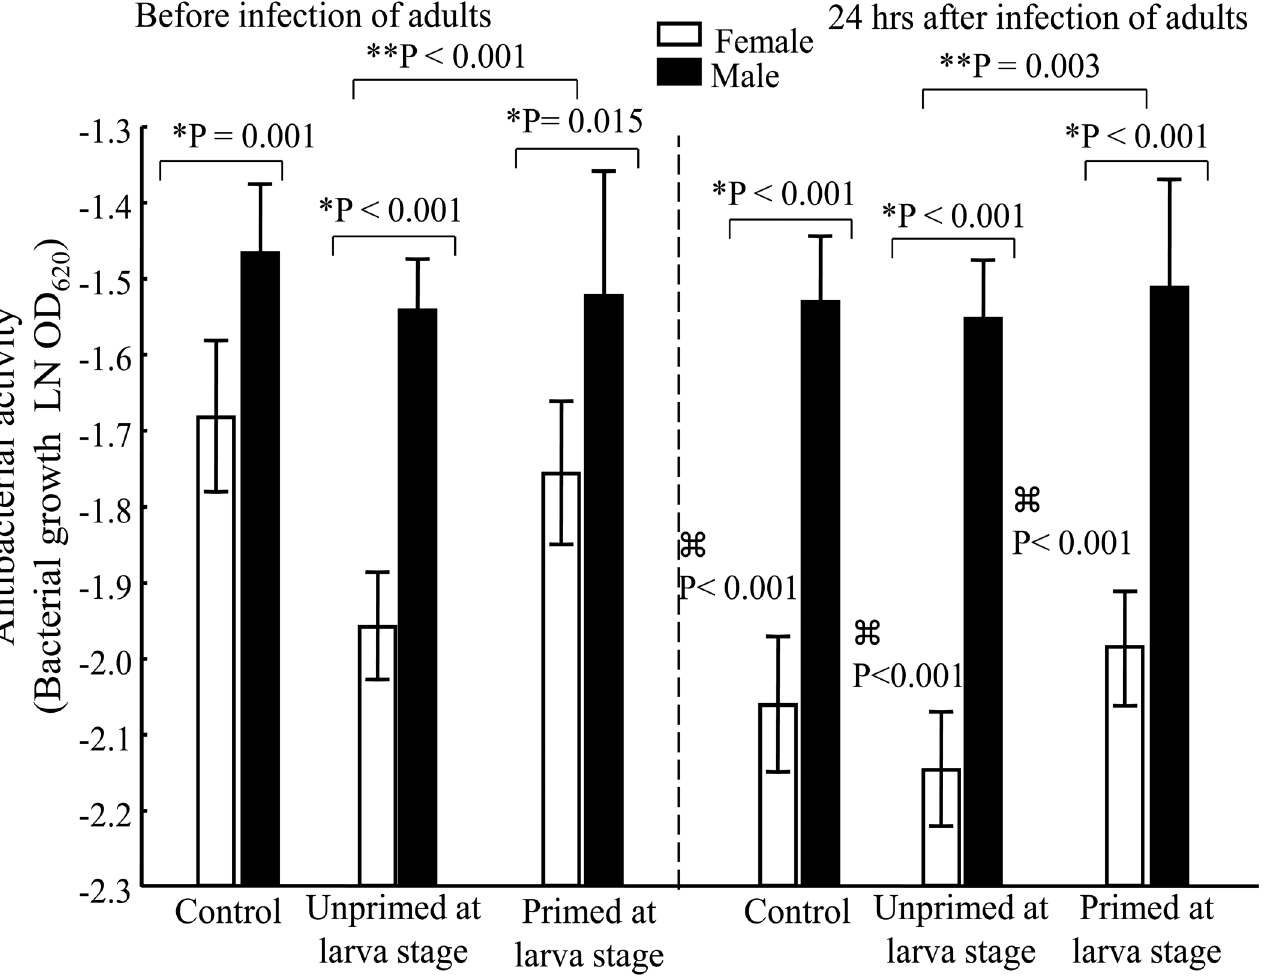
Fig 6. Antibacterial activity of adult mosquitoes before and after infection with E . coli . Higher readings indicate weak antibacterial activity. ( * ) indicates a significant difference between genders within each treatment group (UnPr, Pr). ( ** ) indicates a significant difference between the UnPr and Pr groups (only for females). ( ⌘ ) indicates a significant difference between measurements before and after infection of adults (only for females). Number of samples per group before infection: ♀ = 7, ♂ = 10 for C; ♀ = 16, ♂ = 18 for UnPr; ♀ = 11, ♂ = 3 for Pr. Number of samples per group after infection: ♀ = 10, ♂ = 11 for C; ♀ = 14, ♂ = 14 for UnPr; ♀ = 14, ♂ = 4 for